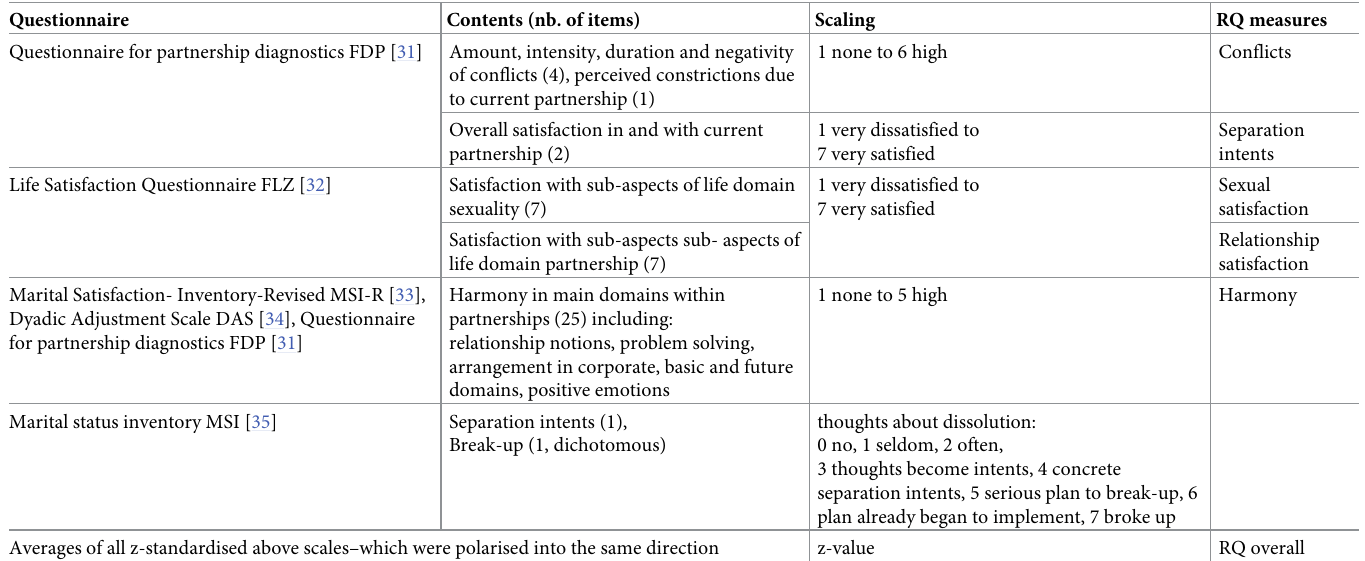
Table 2. Self-assessed aspects of RQ